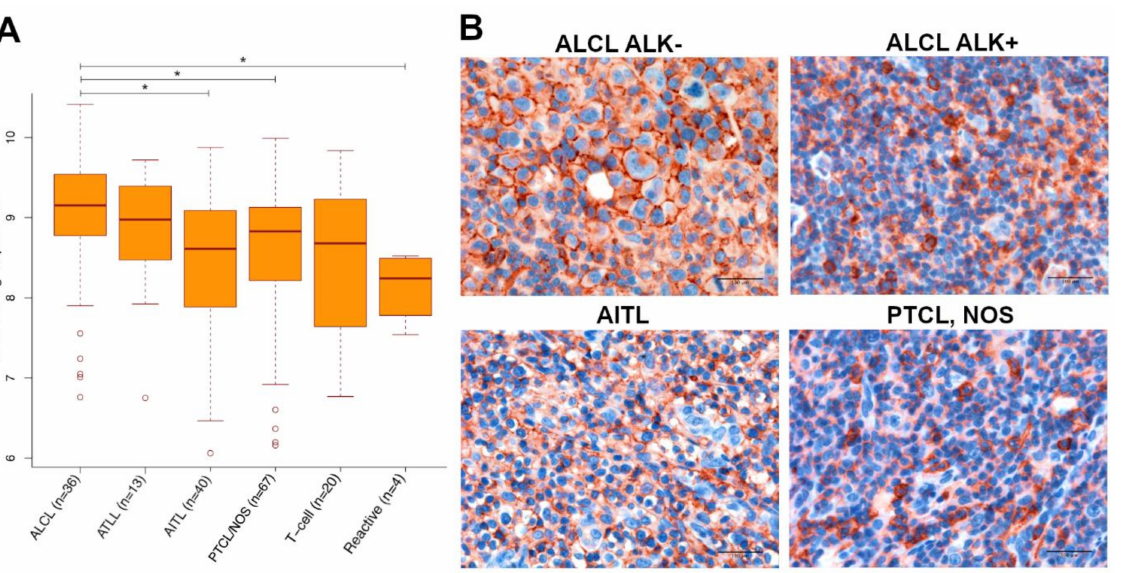
Figure 1. SELPLG differential expression in T-cell specimens and PSGL-1 expression in IHC analysis. ( A ) Histogram representing SELPLG gene expression in T-cell specimens using GEP data analyzed by Fisher’s protected least significant difference (PLSD) post hoc test. * = adjusted p -value < 0.05. ( B ) IHC analysis of PSGL-1 expression intensity in ALK- or ALK+ ALCL, AITL and PTCL, NOS specimens. Scale bar: 100 µ